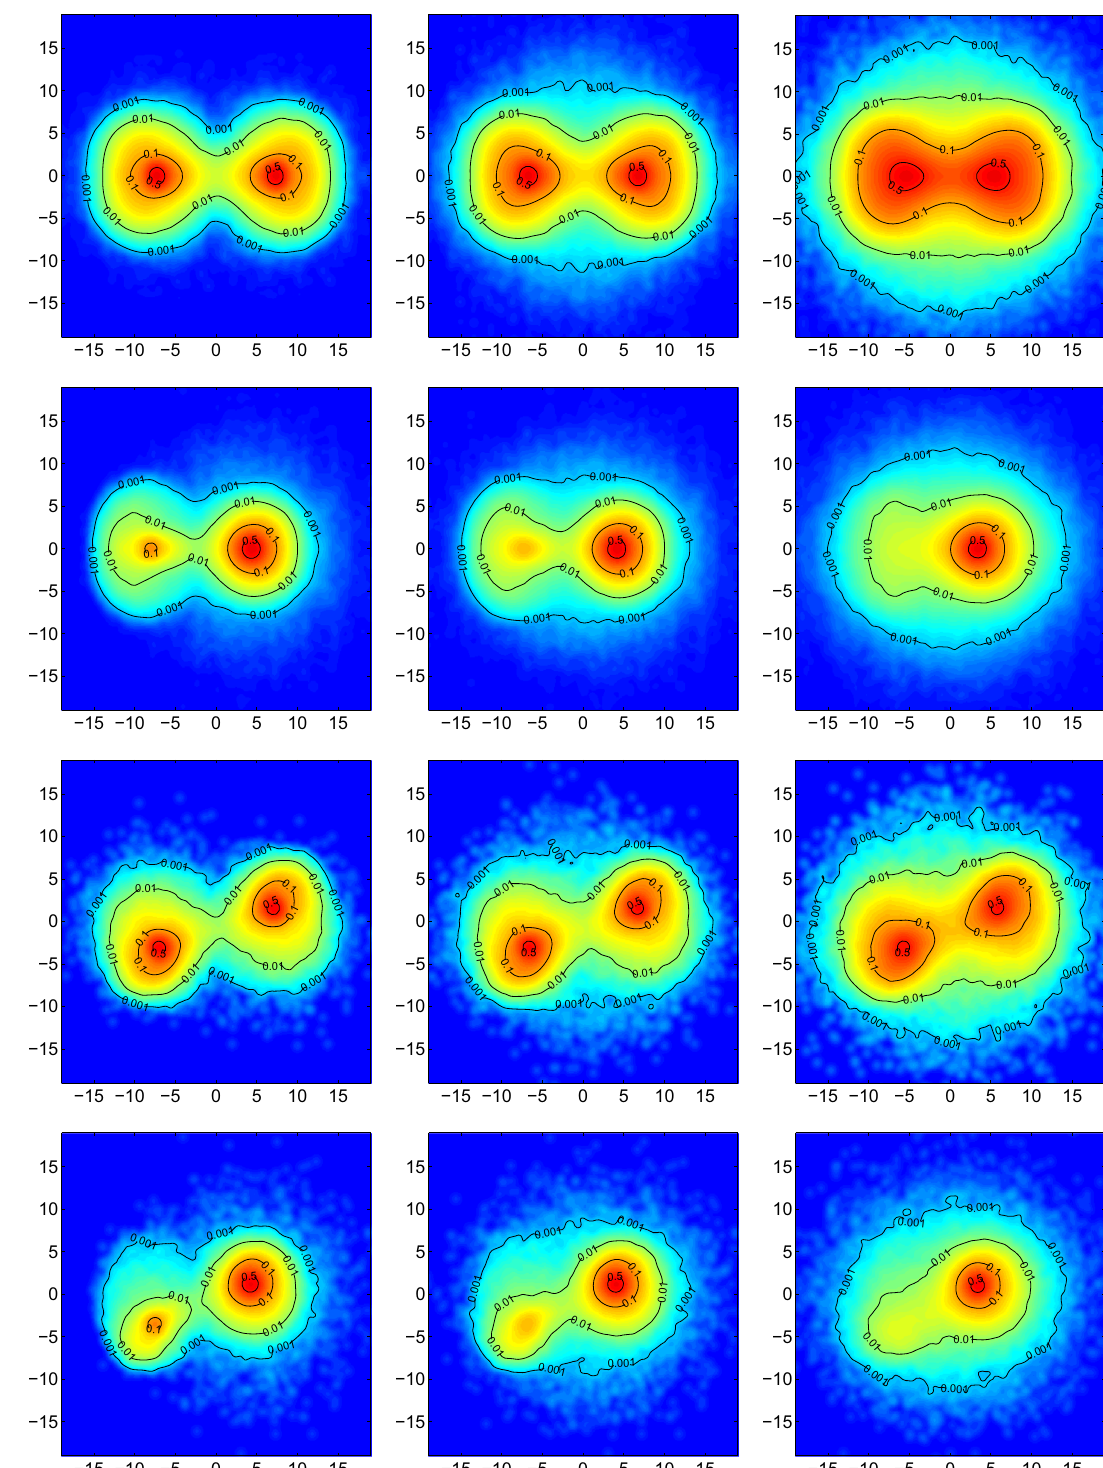
Fig. 3 Thephenomenologiesofpossiblepost-collisionprojectedmass distributions in collisions of galaxy clusters with self-interacting DM. Different galaxy cluster collision scenarios are shown in different rows: the first row is for central symmetric collisions, the second row is for centralasymmetriccollisions,the thirdrow isfornon-centralsymmetric collisions, and the fourth row is for non-central asymmetric collisions.